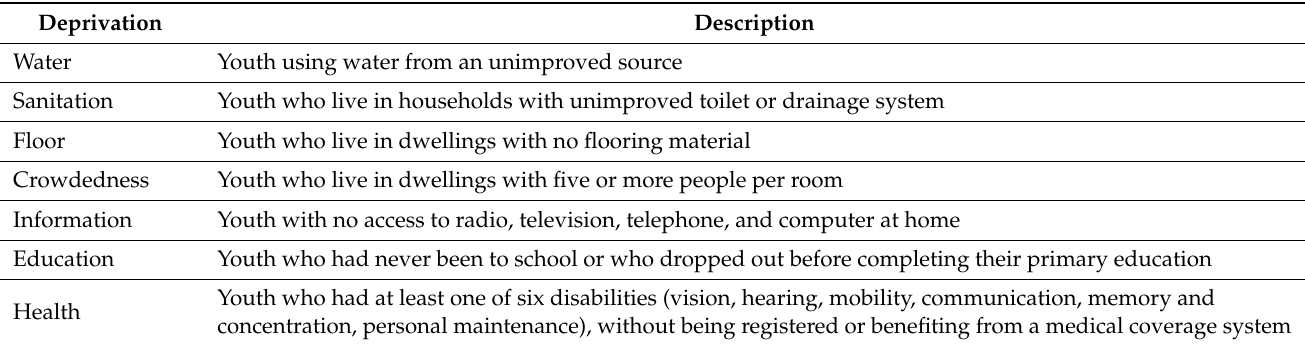
Table 1. The dimensions and indicators employed to measure youth